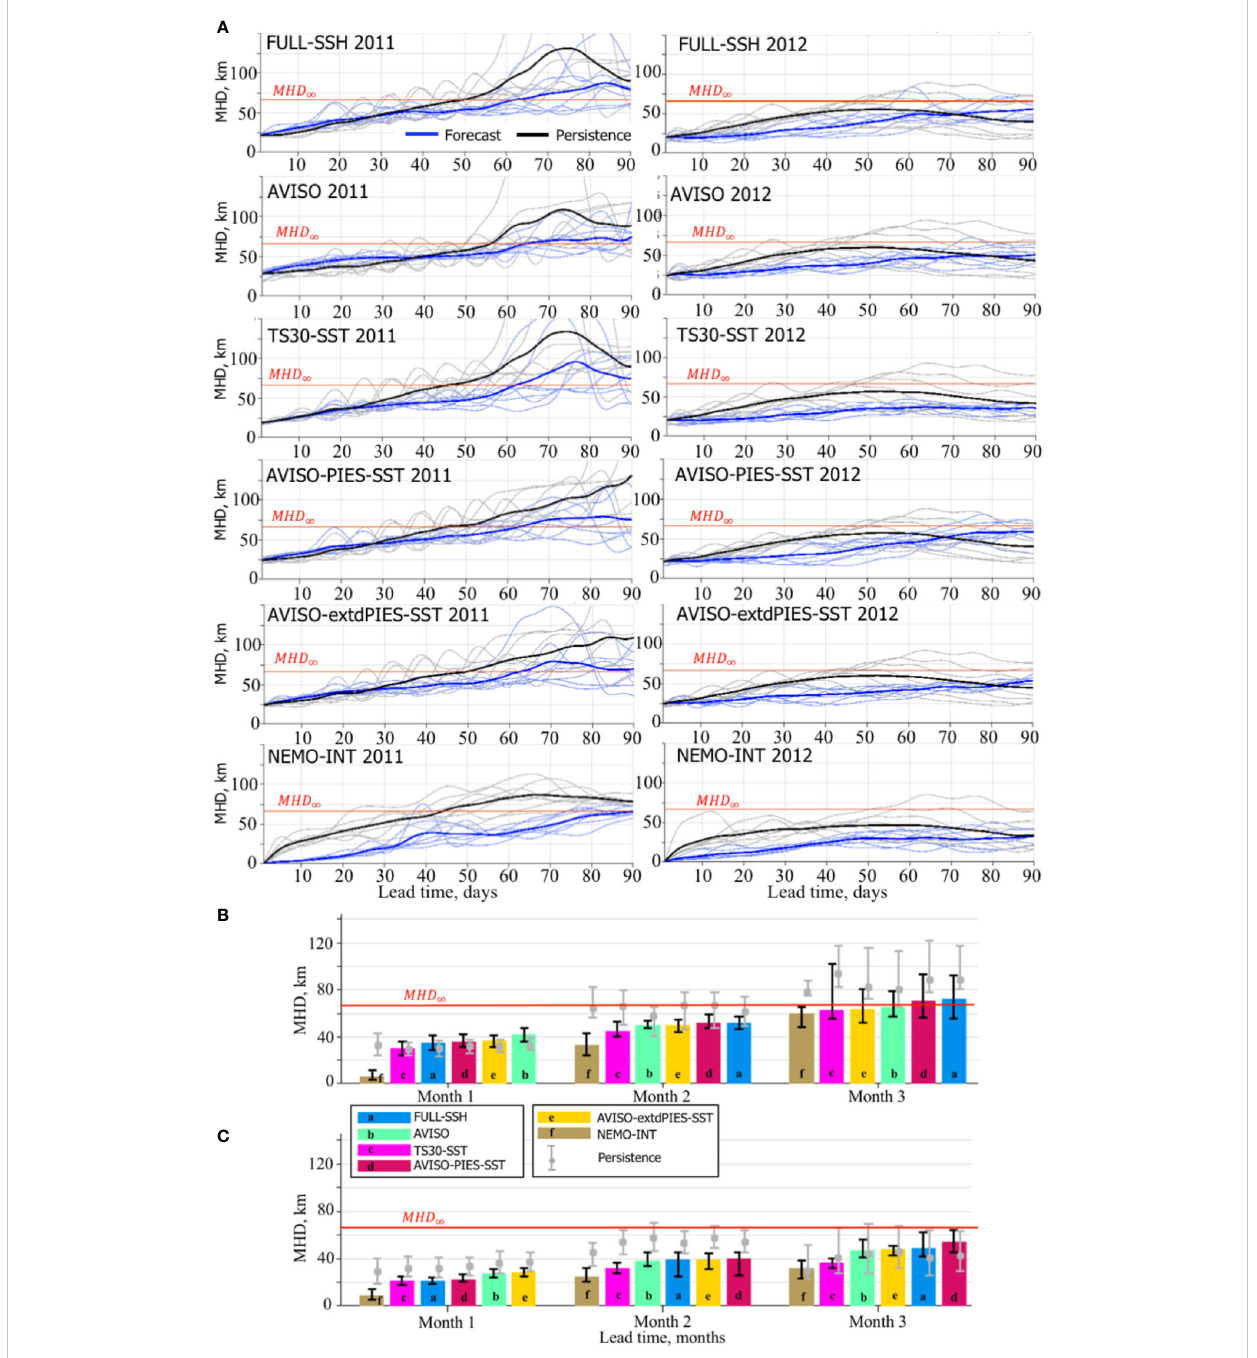
FIGURE 15 MHD scores for LC/LCE fronts derived from OSSE SSH forecasts and the NR. (A) Daily MHD scores for individual forecasts and persistence from the OSSE forecast groups during 2011 (left column) and 2012 (right column). The bold solid lines are the mean MHD scores for the forecasts (blue) and persistence (black). The horizontal red line indicates 95% of the saturation value ( MHD ∞ = 66.3 m). The bar diagrams (B, C) show median MHD score (km) from forecasts within the forecast group (shown with colors and letters corresponding to the OSSE forecast groups) during forecast months 1 through 3 started in May-June 2011 (A) and January-February 2012 (B) . Within each month, the OSSE forecast groups are ranked based on the median MHD score. The vertical black lines on top of the bars indicate the IQR. The grey line and the bullet on the line show the IQR and the median of the persistence corresponding to the OSSE forecasts. The horizontal red line indicates MHD ∞